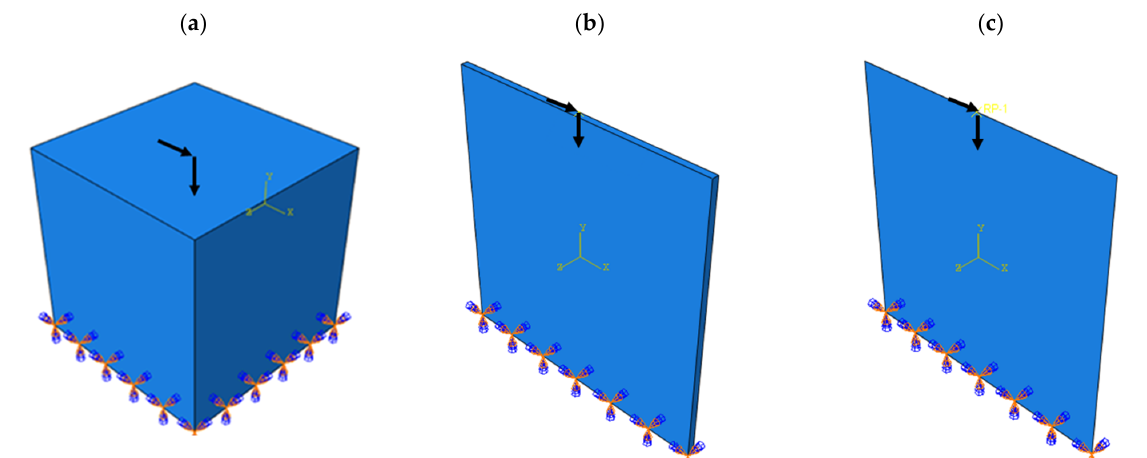
Figure 6. The problem defined in ABAQUS software: ( a ) 3D model, ( b ) 3D model with low thickness, and ( c ) 2D model.